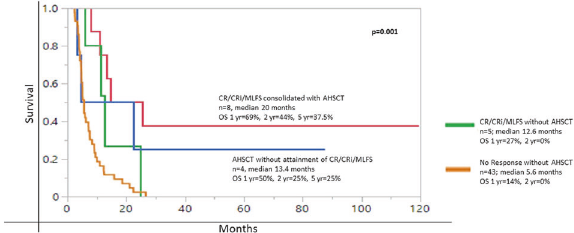
Fig. 2 Overall survival (OS) strati fi ed by AHSCT (allogeneic hematopoietic stem cell transplant) and